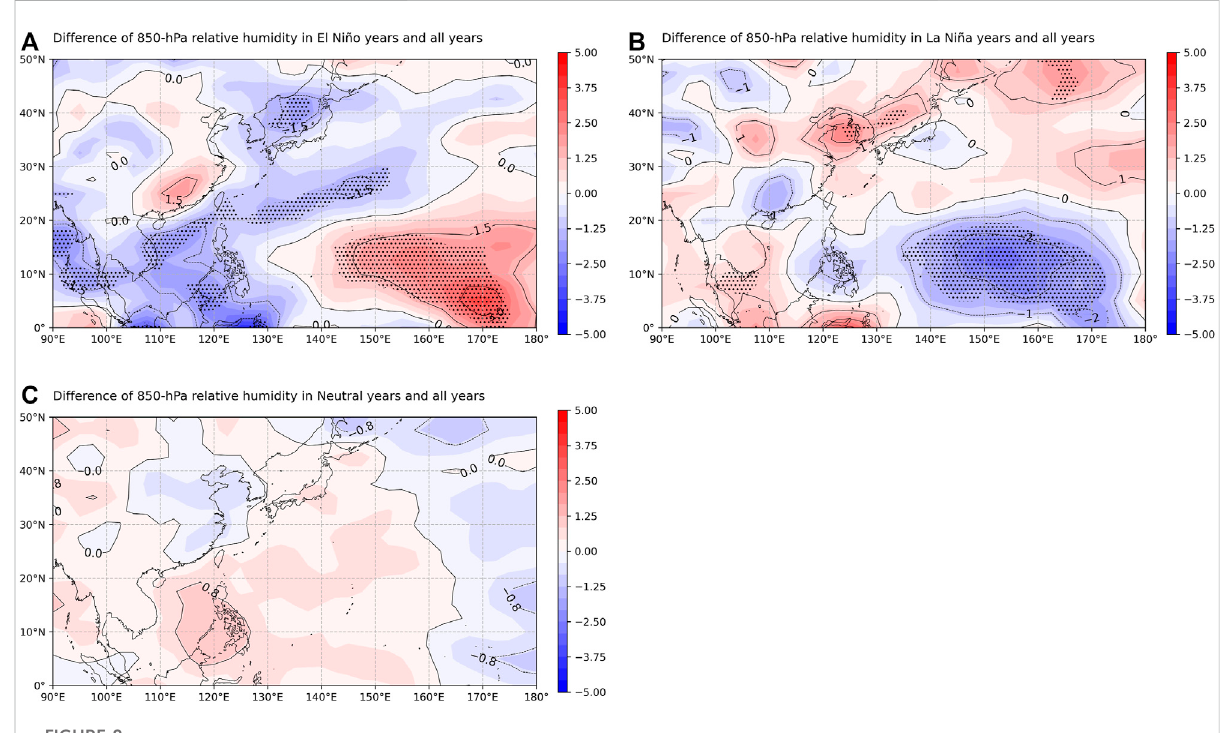
FIGURE 8 Differenceof850-hParelativehumidityduringMaytoDecemberin (A) ElNiño (B) LaNiñayearsand (C) Neutralyearsrelativetotheclimatology of 1979 – 2019. Dots denote differences signi fi cant at 95% con fi dence based on Student ’ s t